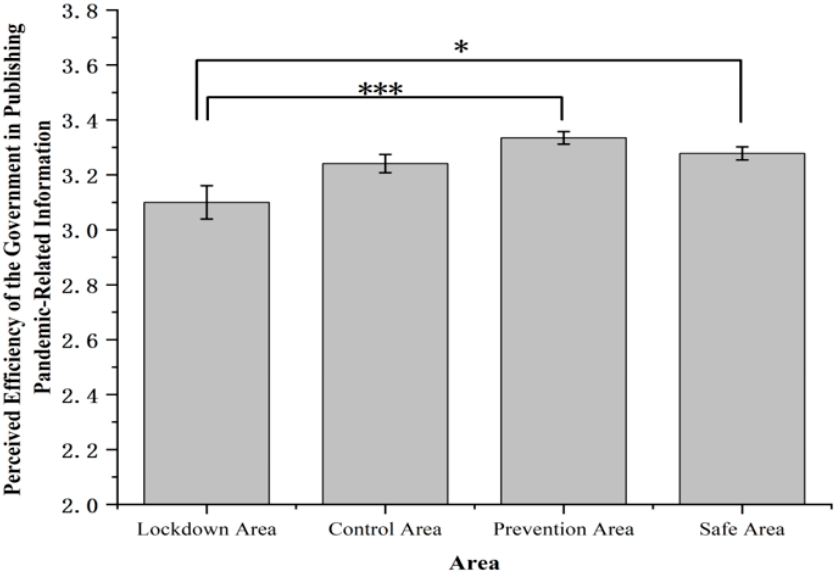
Figure 4. Perceived efficiency of the government in publishing pandemic-related information. Note: The rating of the efficiency of the government in publishing pandemic-related information was measured on a 4-point scale (1 = very slow, 2 = slow, 3 = high, 4 = very high). Error bars represent standard errors. * p < 0.05, *** p < 0.001.